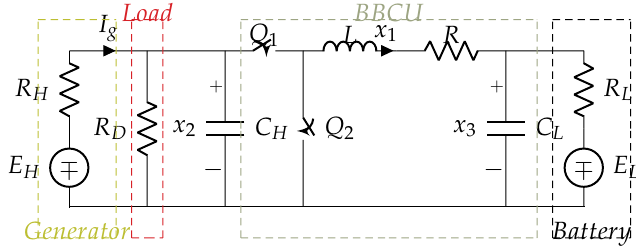
Figure 2. Bidirectional Buck-Boost converter